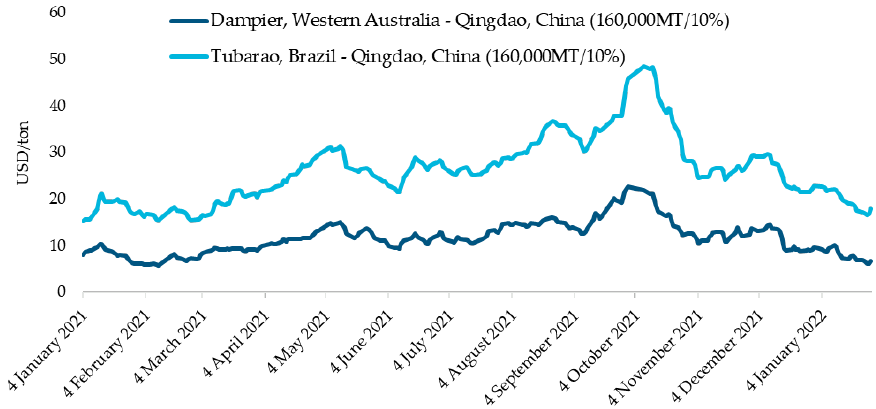
Figure 4. Freight rates for importing iron ore from Australia and Brazil to China in 2021. Source: Shanghai Shipping Exchange.